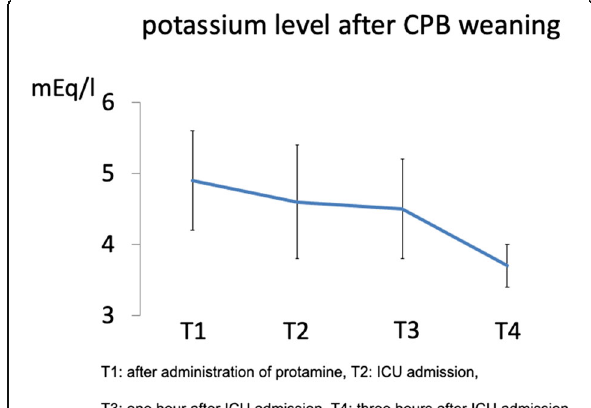
Fig. 1 Potassium level after CPB weaning. T1, after administration of protamine; T2, ICU admission; T3, 1 h after ICU admission; T4, 3 h after ICU admission. The potassium level at T1 was 4.9±0.7 mEq/L, including two cases with levels exceeding 6 mEq/L. After ICU admission, the potassium level gradually decreased. Three hours after ICU admission, the potassium level was 3.7±0.3